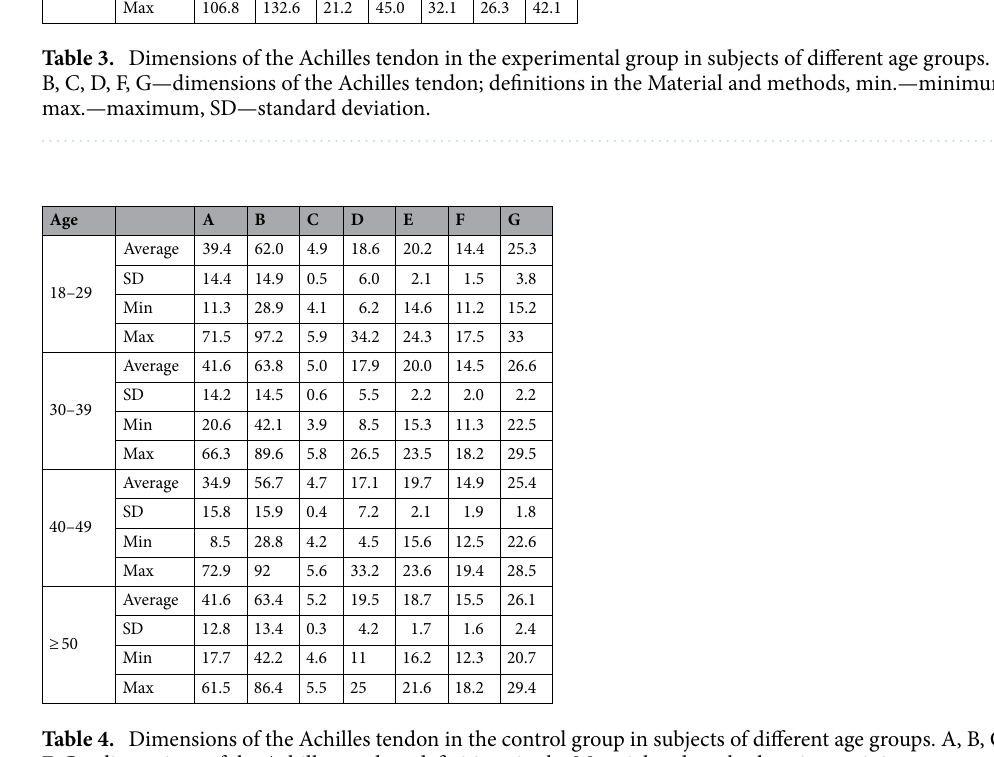
Table 4. Dimensions of the Achilles tendon in the control group in subjects of different age groups. A, B, C, D, F, G—dimensions of the Achilles tendon; definitions in the Material and methods, min.—minimum, max.— maximum, SD—standard deviation.